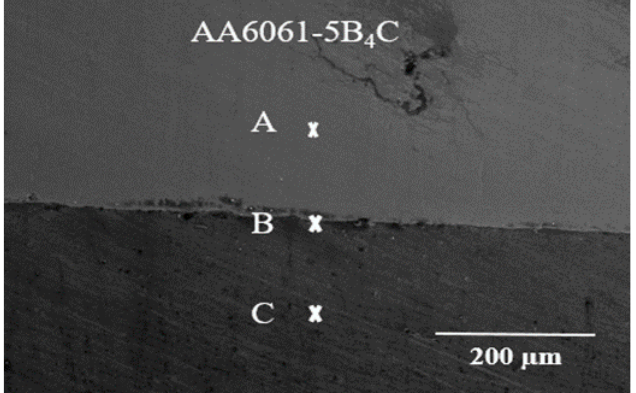
Figure 14. EDX analysis at three points of the AA6061-5%B 4 C friction stud welded specimen in inert atmosphere of argon shielding.